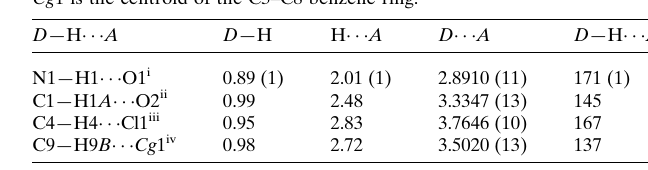
Table 1 Hydrogen-bond geometry (A˚ , (cid:3) ). Cg 1 is the centroid of the C3–C8 benzene ring.